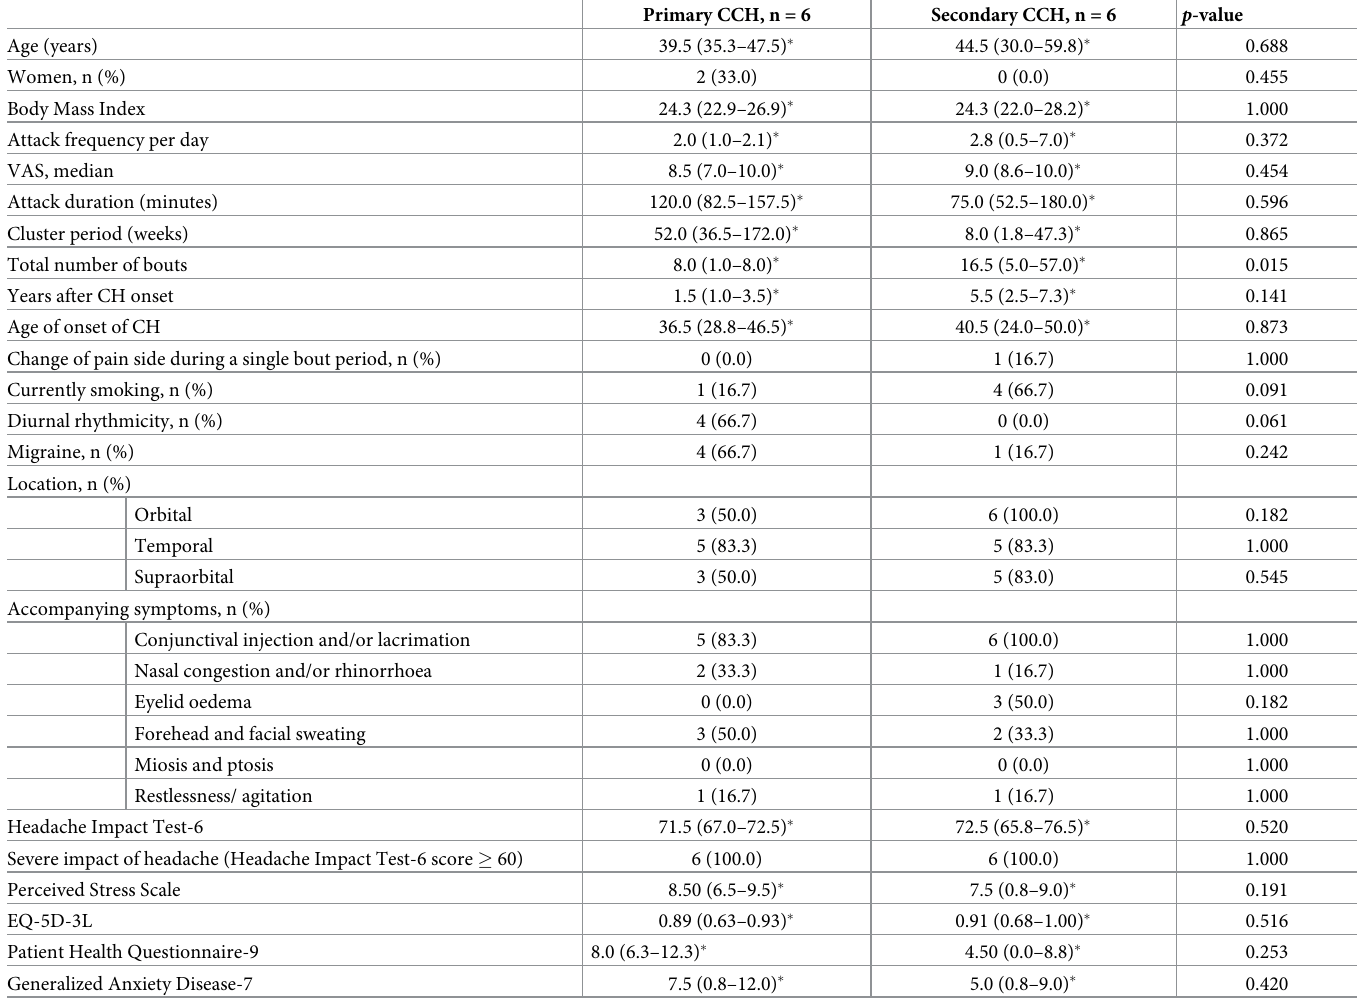
Table 3. Clinical features of participants with primary chronic cluster headache and secondary chronic cluster